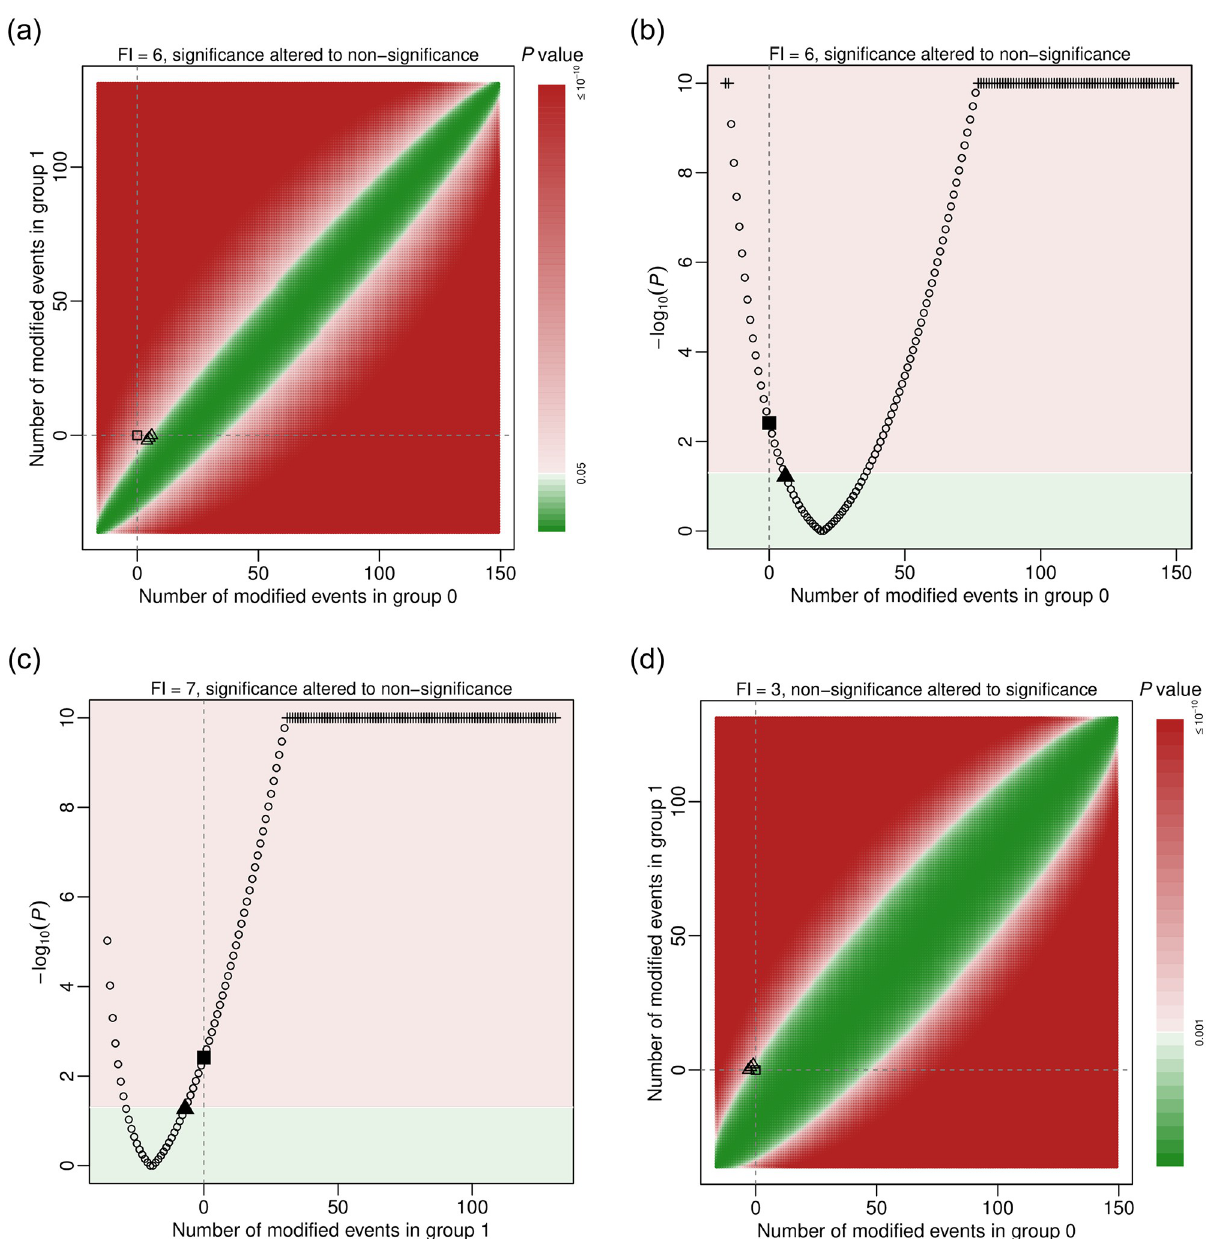
Fig 2. Visualizations of trial 13 in the dataset dat.ad . Points or areas in green indicate non-significant results, and those in red indicate significant ones. Dashed lines represent no modifications in the corresponding groups. Square points represent the original p value, and triangle points indicate minimal modifications that alter the significance. In panels (a) and (d), event statuses are modified in both groups. Each point represents the extent of the p value corresponding to a specific combination of event status modifications in groups 0 and 1. In panels (c) and (d), event statuses are modified in only one group. Plus points represent truncated p values at 10 − 10